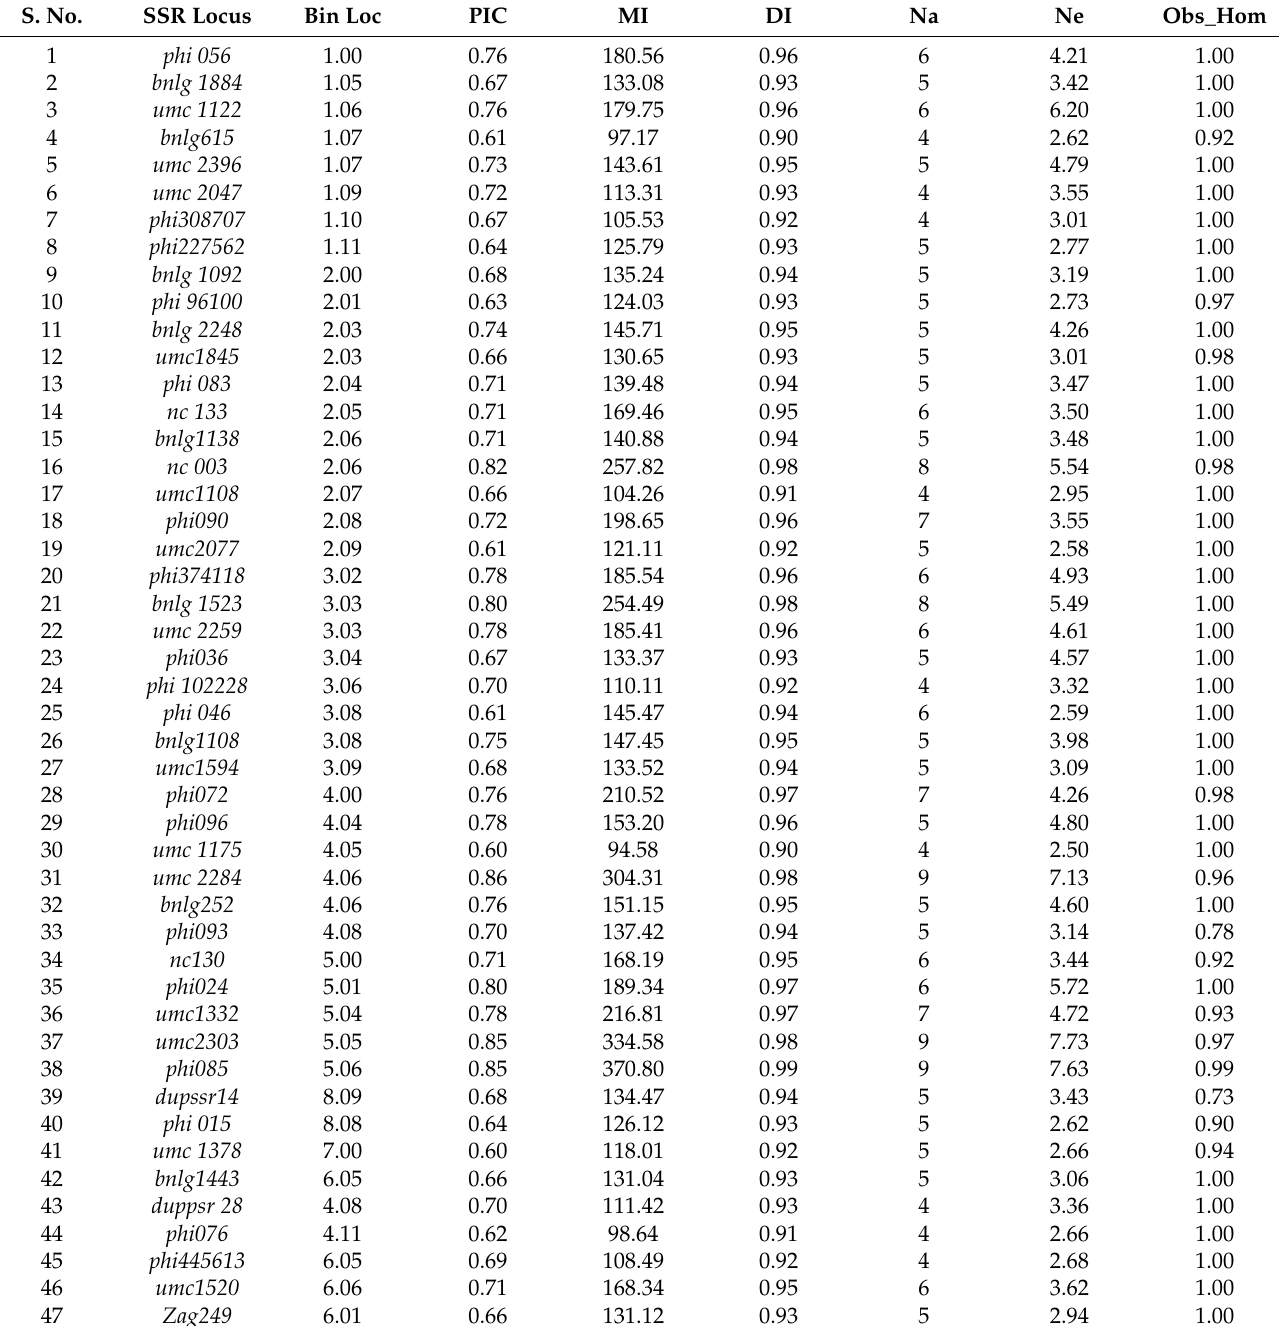
Genetic characteristic of 47 highly polymorphic SSR loci (>0.60) across the 288 maize